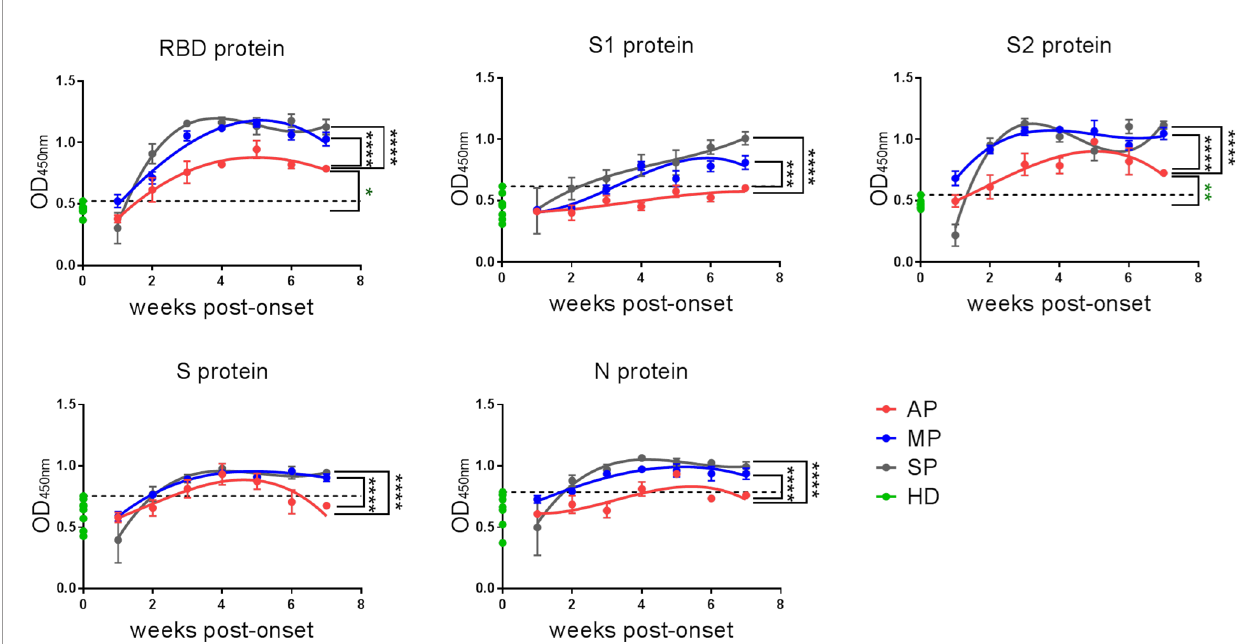
FIGURE 2 | The kinetics of IgG against SARS-CoV-2-RBD/S1/S2/S/N of COVID-19 patients. IgG against RBD/S1/S2/S/N proteins of SARS-CoV-2 in plasma were detected by ELISA. The line is a trend line fi tted by Nonlinear Regression method. OD values were expressed as mean ± SEM. Eight healthy donor plasma samples collected in 2017-2018 served as a control group (HD group) in this experiment. Threshold (dashed line) was de fi ned as mean (of HD group) + 3SD. One-way ANOVA with Holm-Sidak ’ s multiple comparisons test was used. A p-value of ≤ 0.05 was considered statistically signi fi cant (*p-values of ≤ 0.05; **p-values of ≤ 0.01; ***p-values of ≤ 0.001; ****p-values of ≤